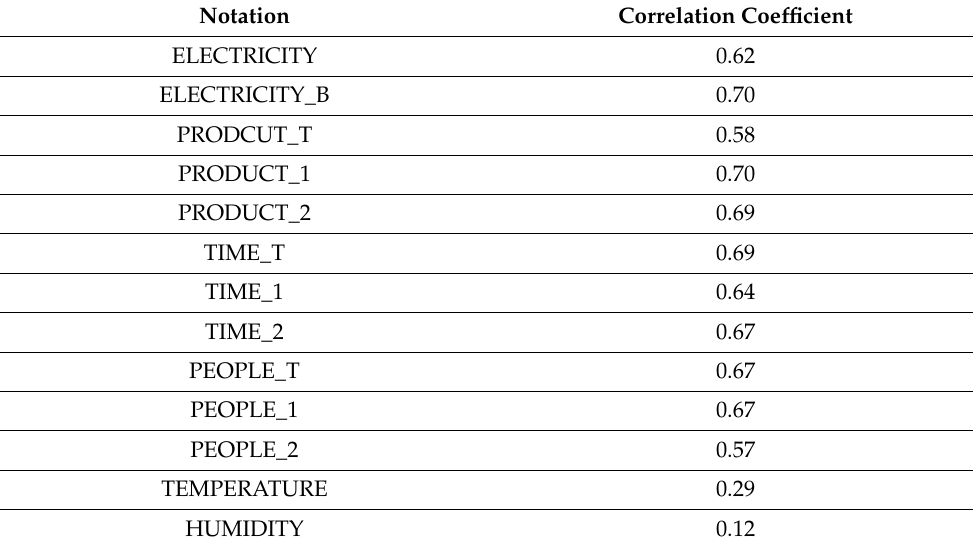
Table 6 lists the 12 types of data schema secured for predicting LNG consumption. The